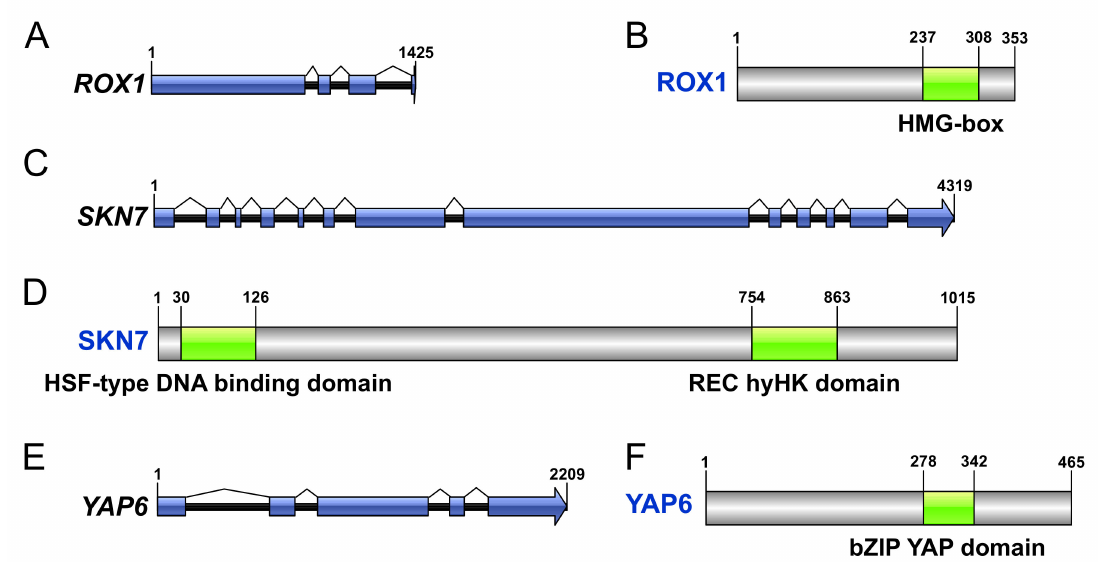
Figure 1. Bioinformatic characterization of ROX1 , SKN7 , and YAP6 in X. dendrorhous . Graphical representations of genes ROX1 ( A ), SKN7 ( C ), and YAP6 ( E ) identified in X. dendrorhous are shown, where blue linked boxes indicate its coding region as exons. The gene products ROX1 ( B ), SKN7 ( D ), and YAP6 ( F ) are represented with gray boxes, corresponding to their translated sequences, where green regions show significant conserved domains (E-value < 0.01). Each conserved domain and its coordinates are